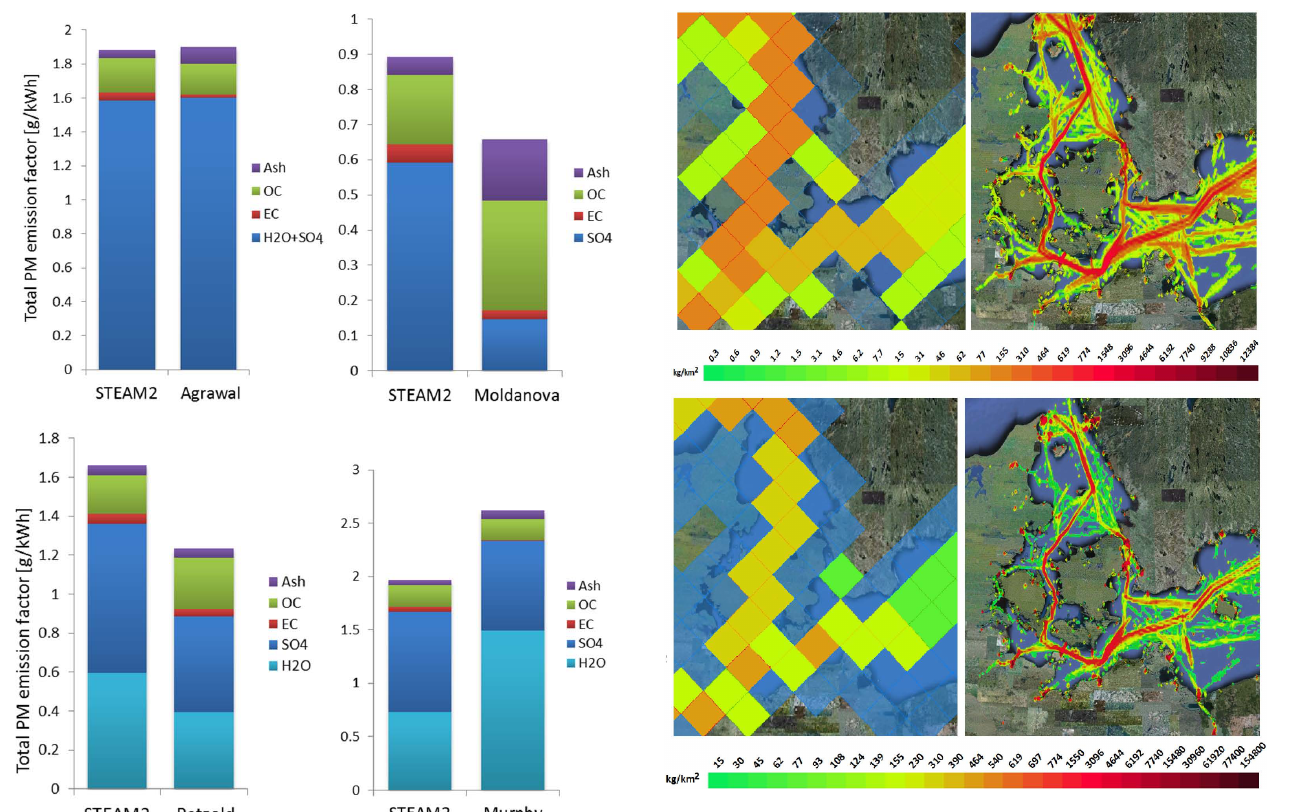
Fig. 12. A comparison of the emission inventories by EMEP (left- hand panels) and STEAM2 (right-hand panels) for the marine re- gions surrounding the Danish straits in 2009. The upper and lower panels represent the predicted annual emissions for PM and CO, respectively. For EMEP, the transparent blue color indicates emis- sion estimates lower than 7.7kgkm − 2 and 77kgkm − 2 , for PM and CO, respectively. Grid resolution: 50 × 50km for EMEP and 1 . 9 × 3 . 4km for